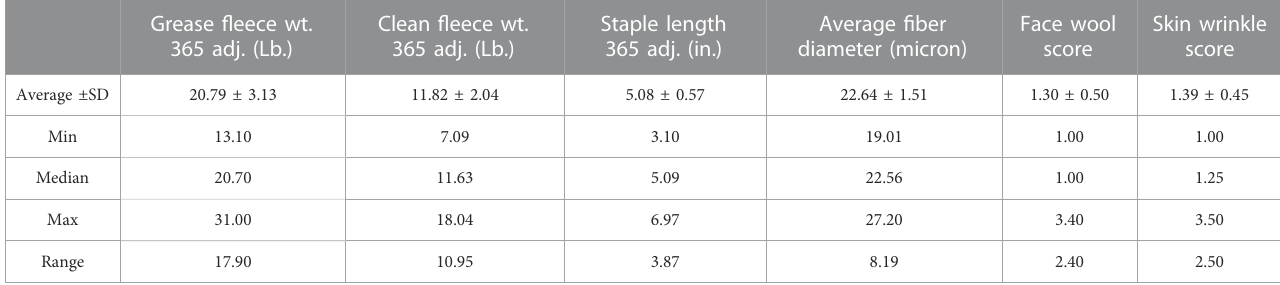
TABLE2Descriptivestatisticsofwoolqualitycharacteristics.Woolqualitycharacteristicsofthe313studyramscollectedfromNDSUandUWYcentralperformanceram tests over 3 years. Grease fl eece wt. 365 adj.